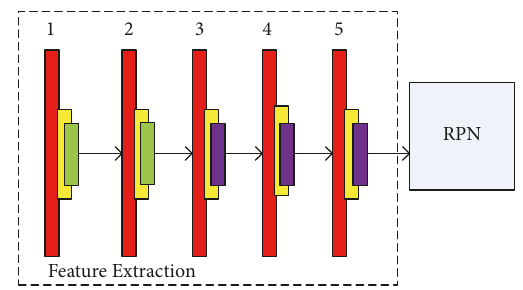
Figure 3: Faster-RCNN network